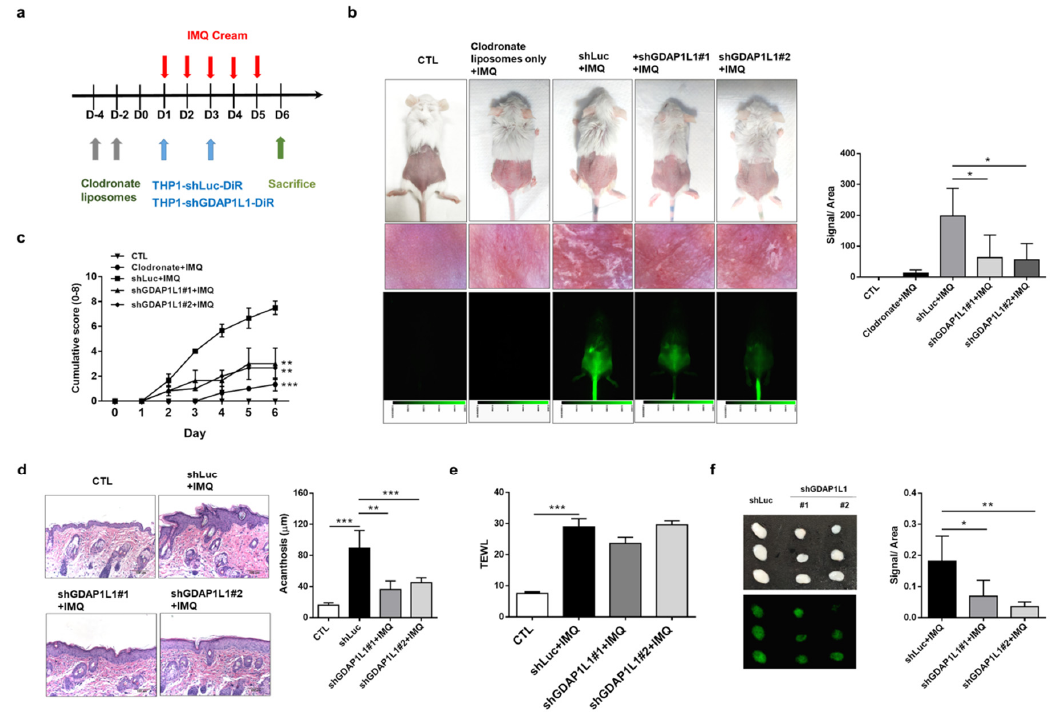
Figure 4. GDAP1L1 inversely regulated the macrophage numbers in lesional skin and the skin draining lymph node, and the histological changes in IMQ-induced psoriasis-like inflammation. ( a ) Experimental schedule for DiR-labeled control or GDAP1L1-deficient THP1 macrophage transplantation into the macrophage-depleted psoriasis-like inflammation model. ( b ) Phenotypical and microscopic images of IMQ-induced macrophage-depleted psoriasis-like inflammation on mouse back skin with and without control or GDAP1L1-deficient THP1 macrophage transplantation. The in vivo biodistribution of DiR-labeled THP1 cells of the skin was monitored using Pearl Impulse (Li-Cor, NE, USA) after intravenous injection in a mouse. In vivo accumulation signal in a mouse, skin injection of DiR-labeled THP1 cells, was quantified in the right panel ( n = 6). ( c ) The cumulative score (erythema plus scaling on a scale from 0 to 4 of each) was depicted (0–8) ( n = 6). ( d ) Histological assessment of back skin by H&E staining and thickness ( μ m) measured using an image analysis system in the right panel ( n = 8). ( e ) Transepidermal water loss (TEWL) was measured at day 6 ( n = 6). ( f ) At day 6, the lymph node was removed and visualized as shown, and ex vivo near-infrared signal of the organs was quantified ( n = 5). All experiments were performed at least three times. * p < 0.05, ** p < 0.01 and *** p < 0.001 when compared to control group. Data are represented as mean ± SEM. Scale bar, 100 μ m.